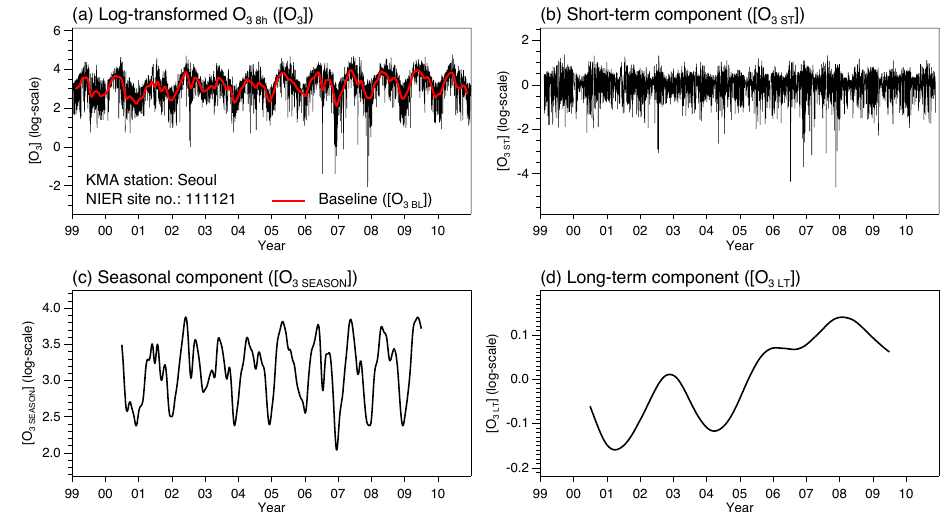
Figure 1. Time series of daily maximum 8h average ozone (O 38h ) at the City Hall of Seoul and its separated components such as (a) log- transformed O 38h time series ([O 3 ]) and its baseline ([O 3BL ]), (b) short-term component ([O 3ST ]), (c) seasonal component ([O 3SEASON ]), and (d) long-term component ([O 3LT ]) by applying the KZ filter. It is noted that the longer window length causes the larger truncation of the result (Wise and Comrie, 2005) since the KZ filter is an iterative moving average process. The baseline (red solid line) is superimposed in (a)